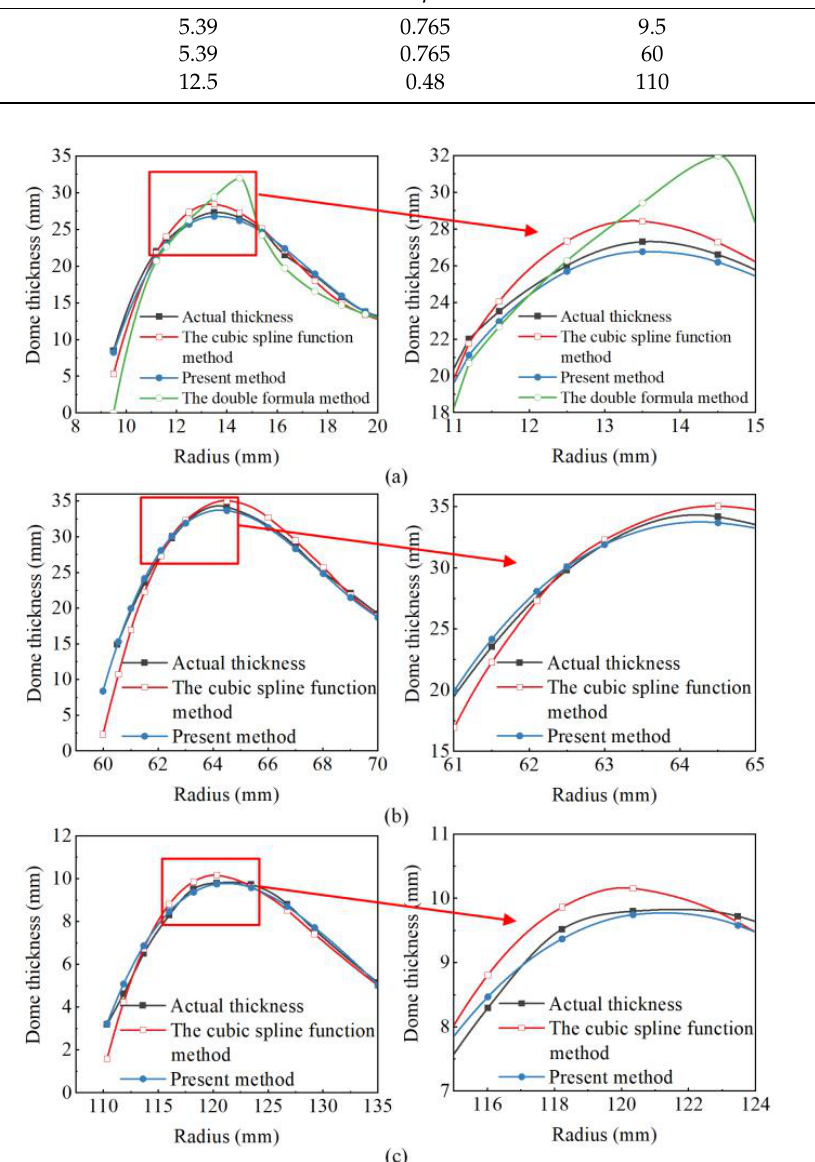
Figure 3. Comparison of analytical and measurement results for dome thickness distribution within two bandwidths: ( a ) Type A vessel, ( b ) Type B vessel, and ( c ) Type C vessel. Table 2. Relative error between the analytical results and the measurement results.